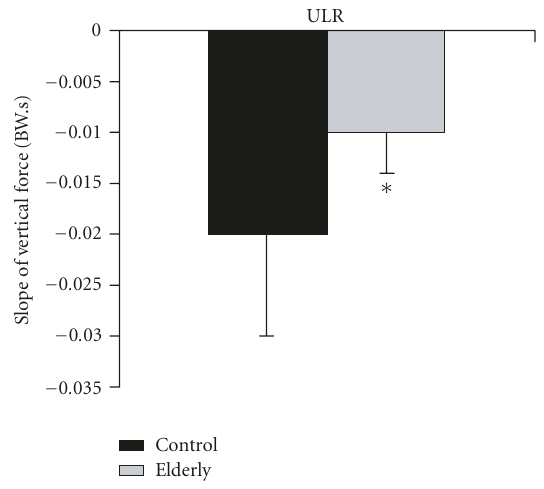
Figure 9: Slope of vertical force during stepping down. ∗ denotes being significantly di ff erent from control subjects ( P < .